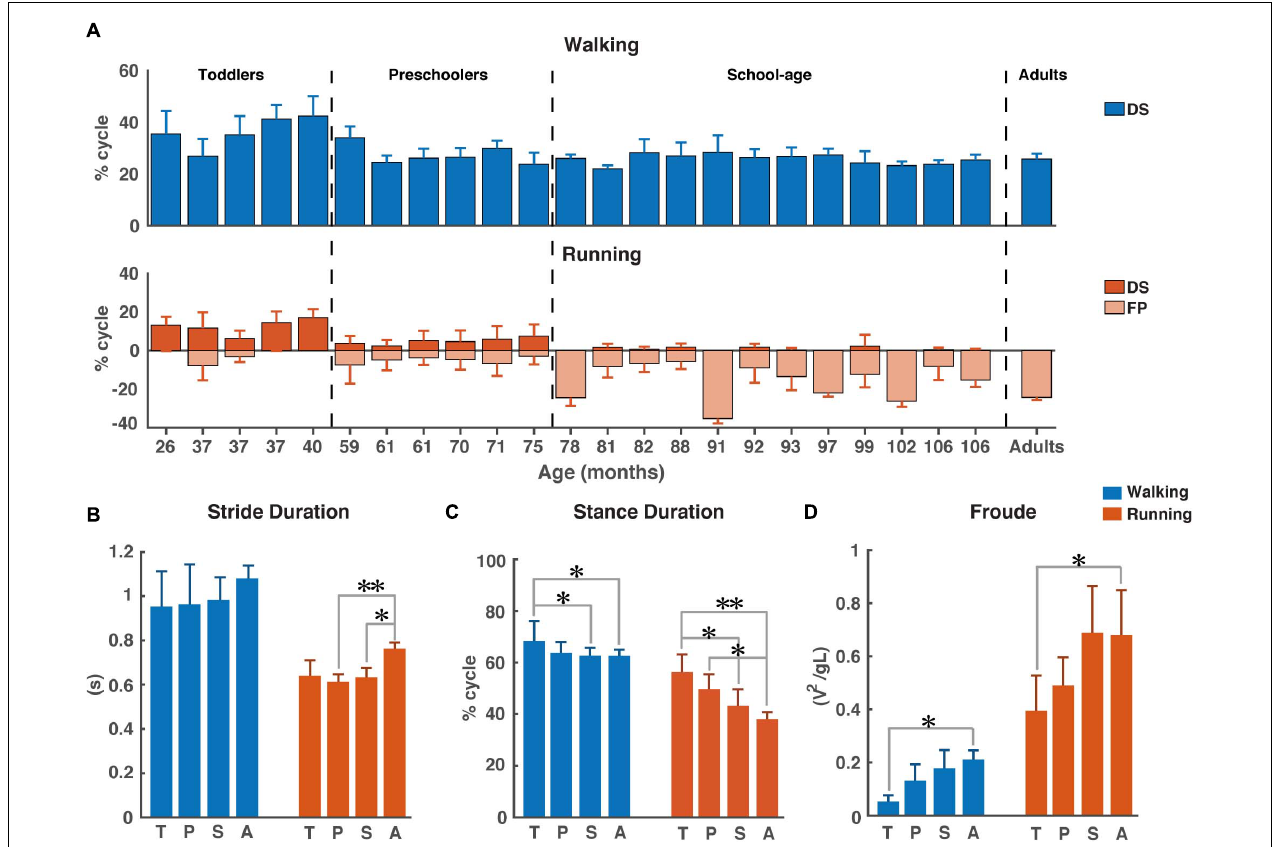
FIGURE 1 | Temporal gait parameters. (A) Percentage double support and flight phase during walking (blue) and running (red). Flight phase is depicted with negative numbers. Vertical dotted lines separate the different groups: Toddlers, Preschoolers, School-age, and Adults, (B) Stride duration for walking and running, (C) Stance duration for walking and running, and (D) Froude number for walking and running. DS, double support; FP, flight phase; s, seconds; T, toddlers; P, preschoolers; S, school-age; A, adults; V, velocity, g, gravitational constant; L, leg length. * p < 0.01 and ** p <